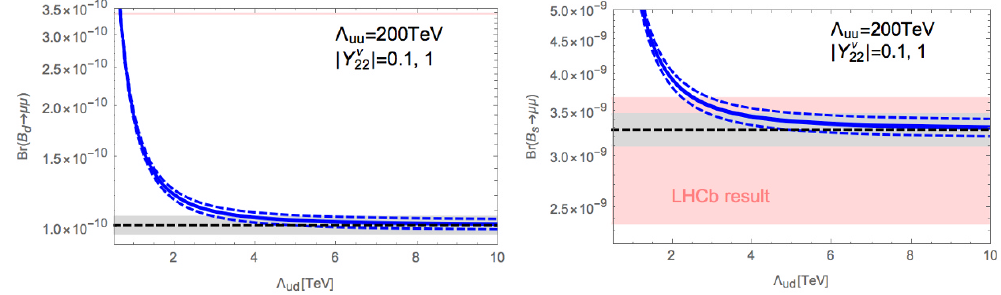
j = 0 : 1 ; 1. Note that the 22